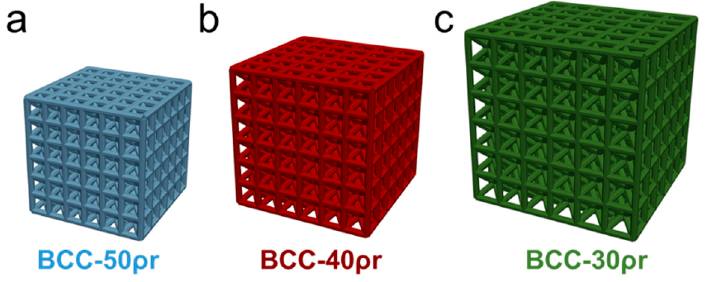
Figure 5. Designs for ( a ) BCC-50 ρ r ( b ) BCC-40 ρ r , and ( c ) BCC-30 ρ r lattices designed with BCC unit cells of 500 µm diameter with 50%, 40%, and 30% relative densities, respectively.